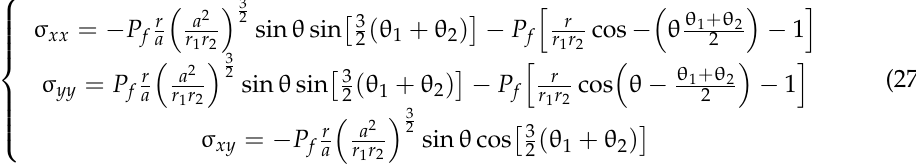
Figure 2. Validation of simulation model. ( a ) mechanical model; ( b ) comparison of simulation results; “*” represents the numerical solution, solid lines represent analytical solutions.